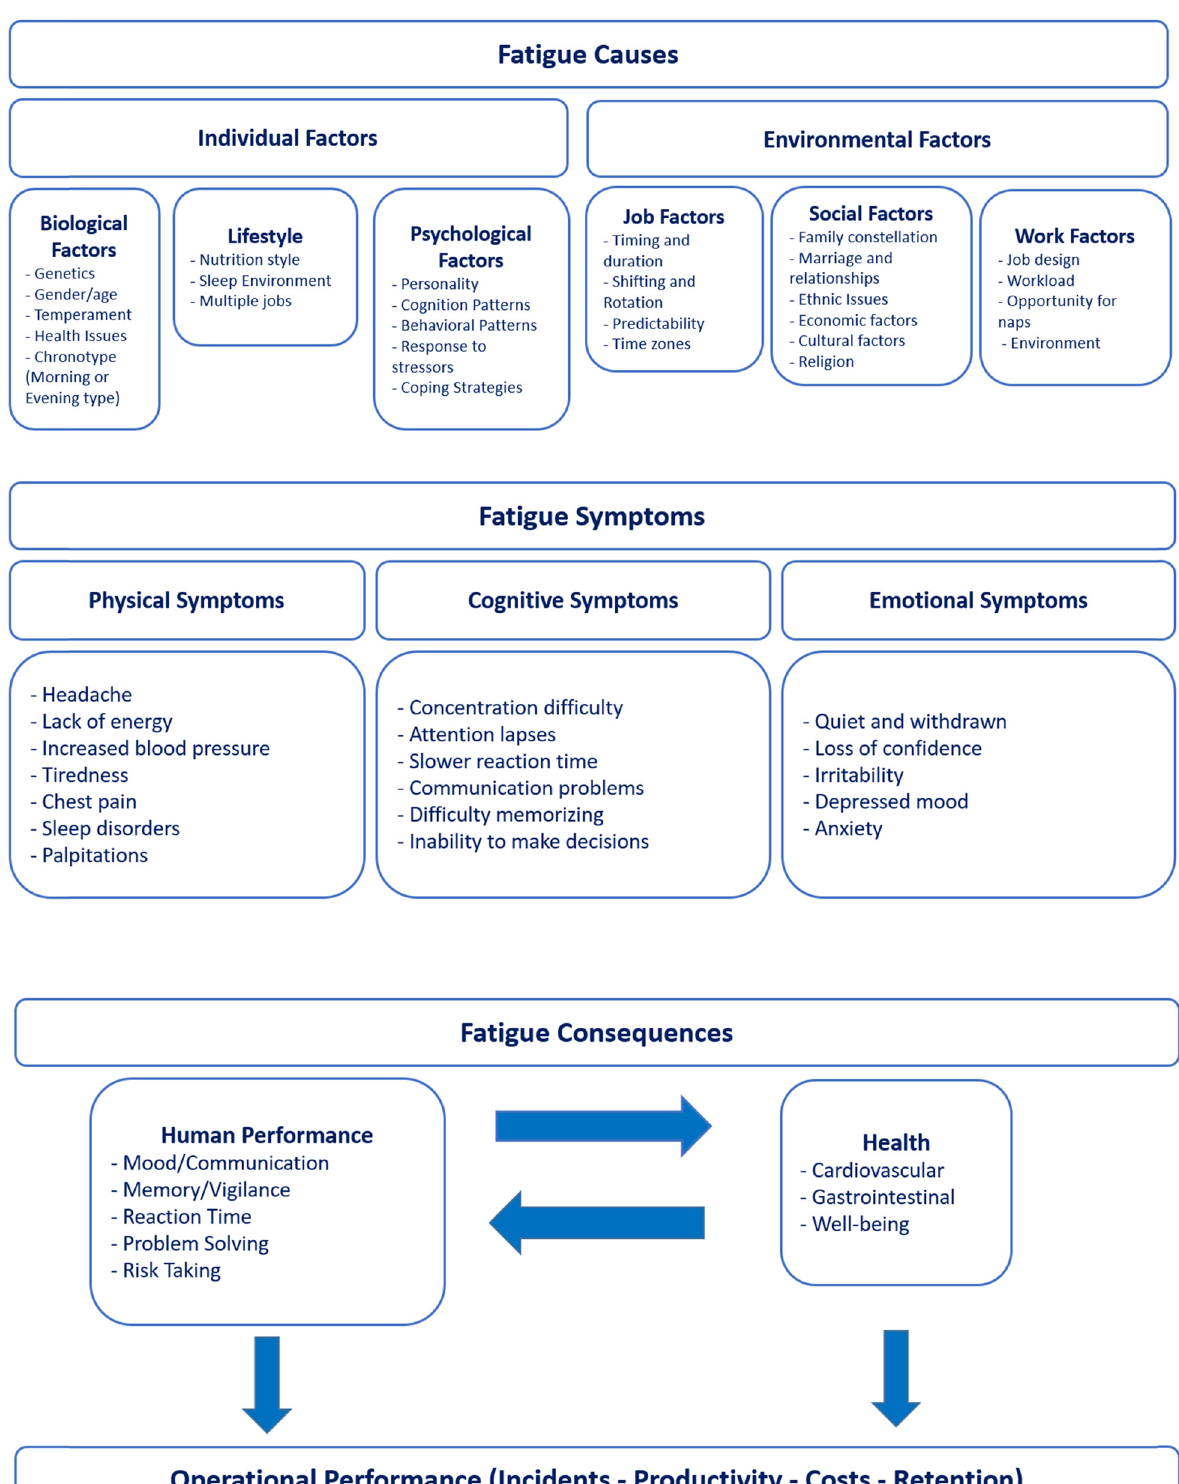
Figure 1: Causes, symptoms, and e ff ects of fatigue. Source: own elaboration based on previous studies [ 19 – 21 ]